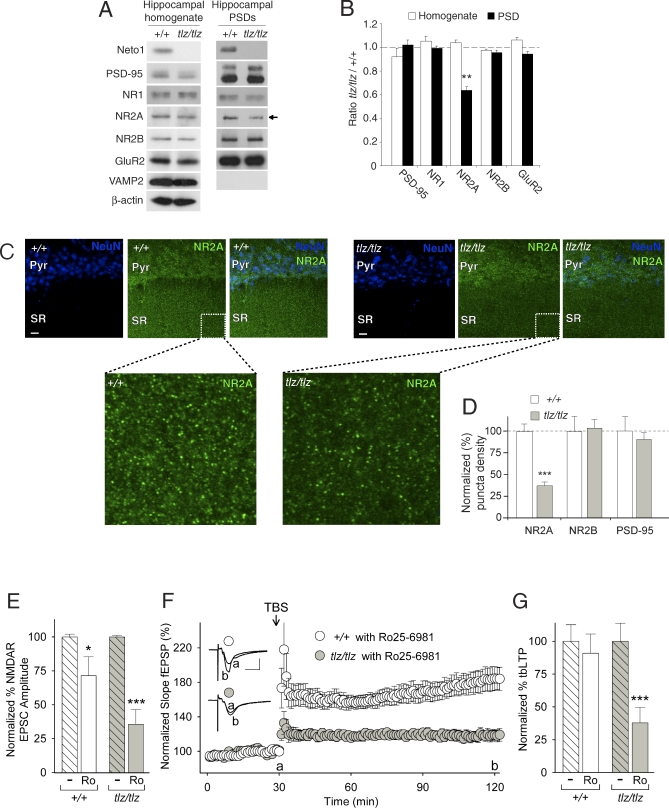
Reduction of NR2A in CA1 and tbLTP Subunit Dependency Switch from NR2A- to NR2B-NMDARs(A) Immunoblots of synaptic proteins in whole hippocampal homogenates (10 μg of protein) and the hippocampal PSD fraction (2 μg of protein) from +/+ and tlz/tlz mice. Antibodies used for detection are indicated at left. Blots shown are representative of four separate experiments.(B) Histogram showing normalized levels of different synaptic proteins in tlz/tlz hippocampal homogenate relative to that of +/+ (white bars), and tlz/tlz PSD fractions relative to that of +/+ (black bars). Band intensity was quantified as a mean grayscale value. **, p < 0.01, t-test, n = 4 pools of five pairs of hippocampi.(C) Confocal micrographs of immunostained hippocampal slices from the CA1 region. Antibodies used are indicated in each box. Scale bar, 10 μm. Pyr, pyramidal cell layer; SR; stratum radiatum.(D) Histogram of relative number of NR2A, NR2B, and PSD-95 puncta in CA1 stratum radiatum between wild-type and Neto1-null (tlz/tlz) hippocampal slices. ***, p < 0.005, Student's t-test; n = 3 mice/genotype.(E) Histogram of pharmacologically isolated NMDAR EPSCs from CA1 neurons in hippocampal slices from +/+ (n = 5 neurons) and tlz/tlz (n = 6 neurons) mice before (−) and 40 min after Ro25–6981 (Ro; 2 μM). NMDAR EPSCs were monitored every 10 s throughout the experiment; the effect of Ro25–6981 had stabilized by 30 min of application. Results are expressed as a percentage of NMDAR amplitude, with the amplitude in +/+ (white bar) and tlz/tlz (filled bar) slices before Ro25–6981 treatment normalized to 100%. *, p < 0.05 versus Neto1+/+ (+/+) before Ro25–6981 treatment (−). ***, p < 0.001 versus tlz/tlz before Ro25–6981 treatment (−).(F) Summary scatter plot shows the grouped normalized fEPSP slope plotted every 1 min in Ro25–6981-treated slices (in ACSF beginning 30–40 min before theta-burst stimulation with a final concentration of 2 μM) from +/+ (n = 16 slices) and tlz/tlz (n = 9 slices) mice. Inset: average of six consecutive fEPSPs recorded at the times indicated (a or b; scale bars: 10 ms, 0.5 mV).(G) Histogram showing the theta-burst stimulation-induced increase in fEPSP slope 90 min after theta-burst stimulation in slices from +/+ and tlz/tlz mice without (−) and with Ro25–6981 (Ro) treatment. Results are expressed as a percentage of theta-burst stimulation-induced increase in fEPSP slope (% tbLTP) with tbLTP in +/+ and tlz/tlz slices without Ro25–6981 treatment normalized to 100% (white and filled bars, respectively). ***, p < 0.001 versus tlz/tlz without Ro25–6981 treatment (−). Data are shown as mean ± standard error of the mean (SEM).